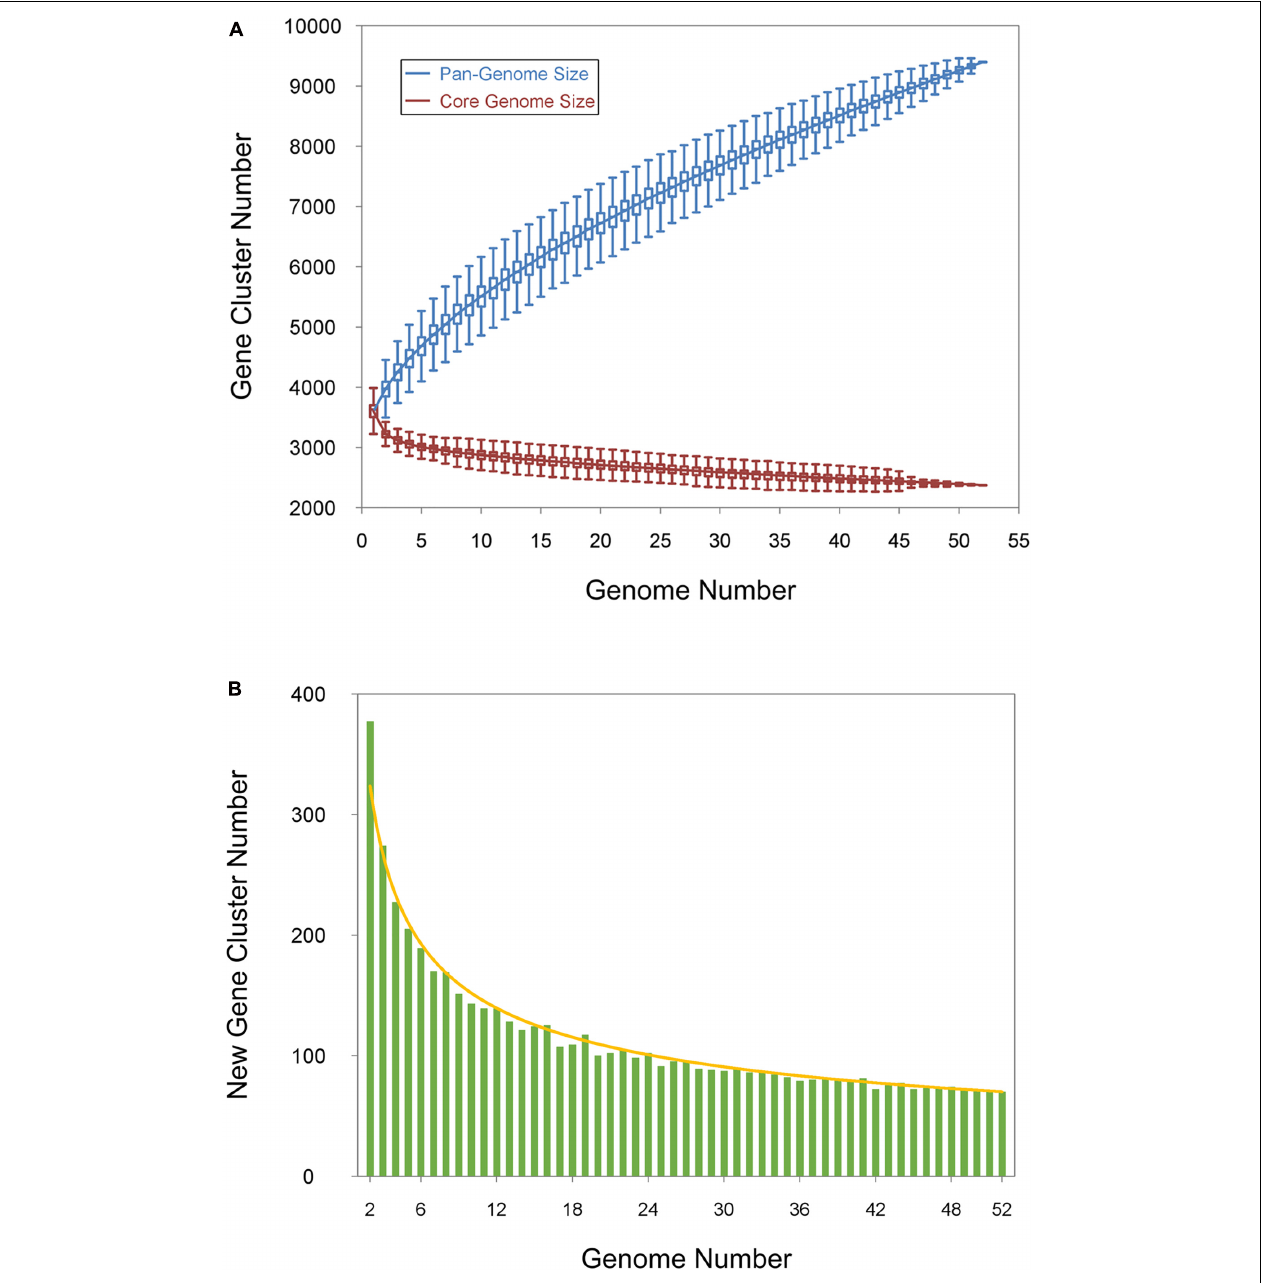
FIGURE 4 | The pangenome curves of Bp group strains. (A) Core and pan-genome calculations for the Bp group. The blue curve shows an open pan-genome; the deduced pan-genome size is y = 726.2n 0 . 552 + 2904.6 ( R 2 = 0.99998). The red curve represents the core genome, and the deduced core genome size is c = 939.4e - 0 . 058 n + 2379.1 ( R 2 = 0.94131). (B) New gene size and curve for Bp -group